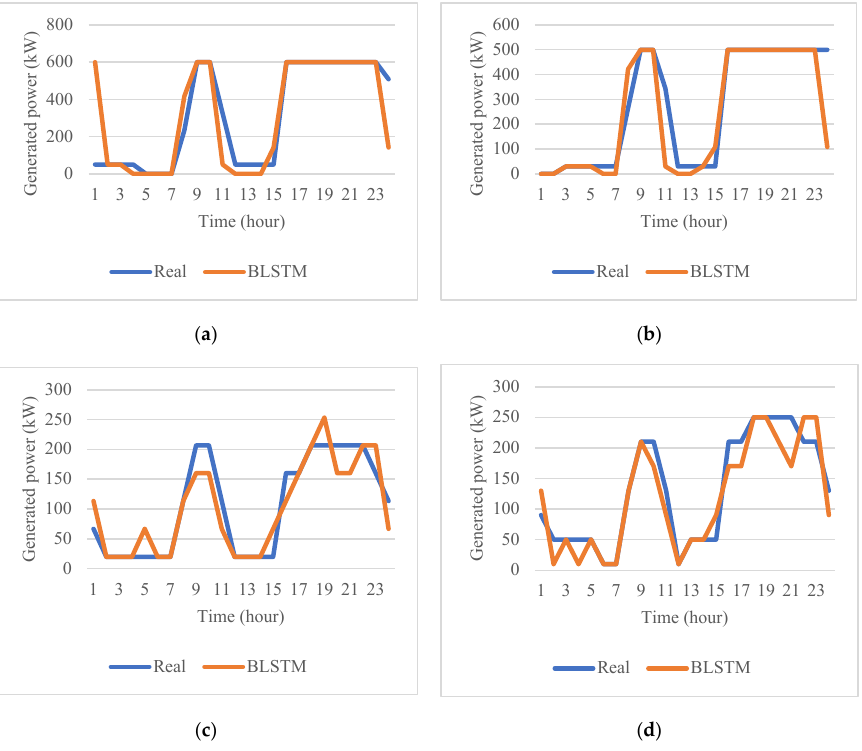
Figure 7. Generated power (kW) by DGs in 24 h for real data and BLSTM methods: ( a ) DG1; ( b ) DG2; ( c ) DG3; ( d ) DG4.